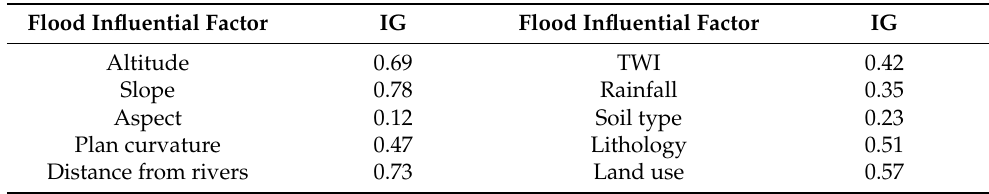
Table 2. Importance of flood influential factors for flood modeling.